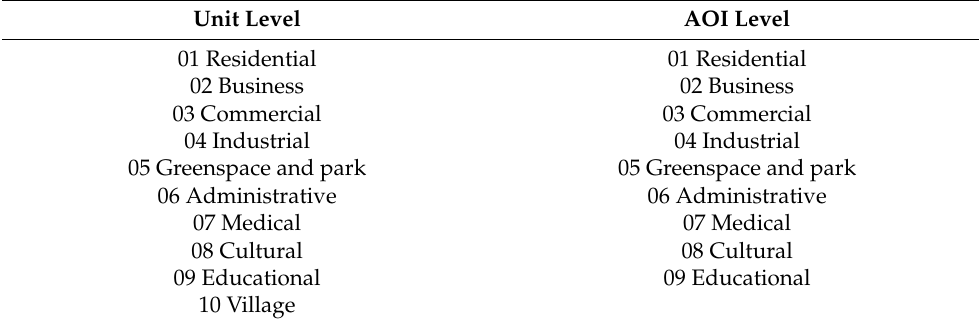
Table 1. The redefined classification system of essential urban land use categories-area of interest